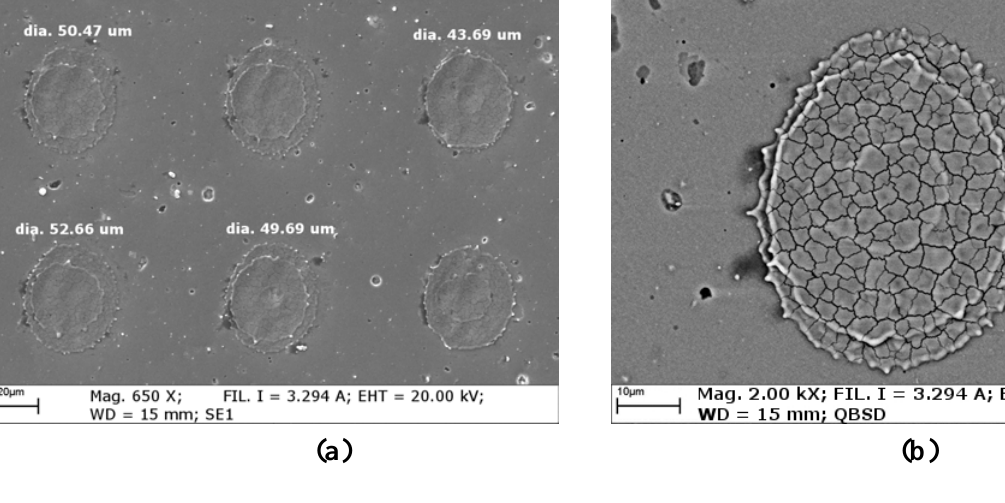
Figure 6. SPM image of a single